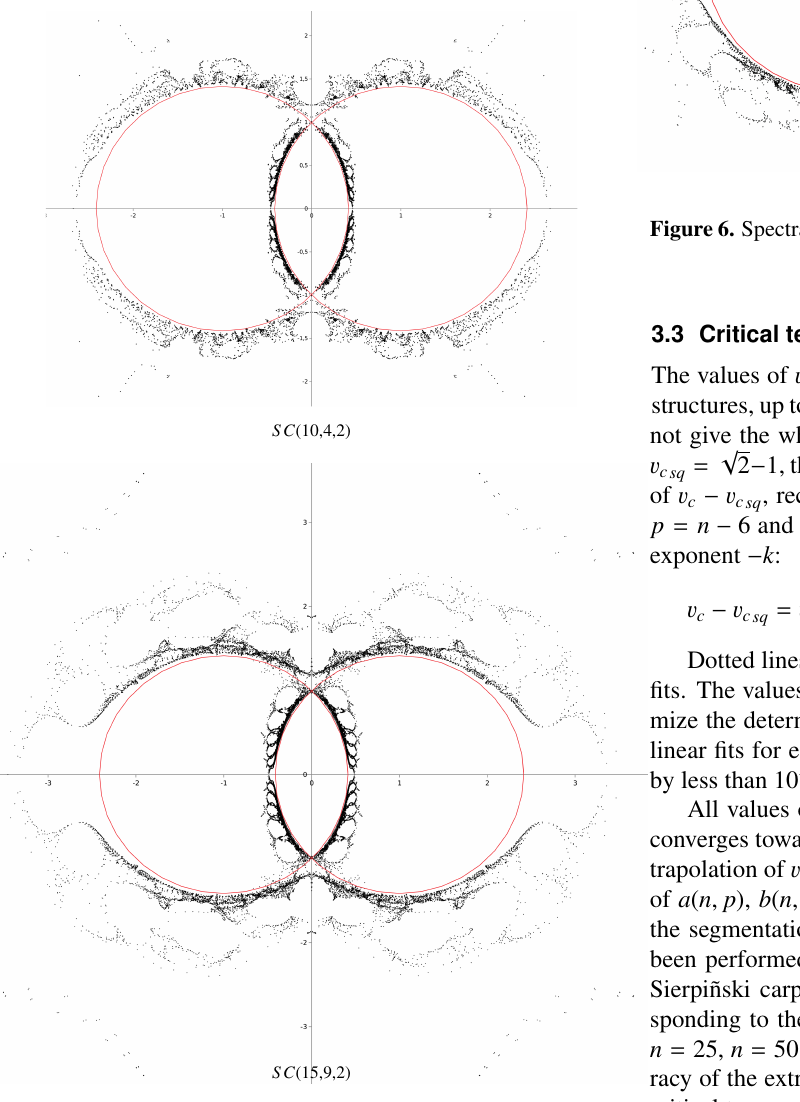
Figure 5. Spectra of the Ising model on SC ( n ; p ; k ) for p = n (cid:0) 6.